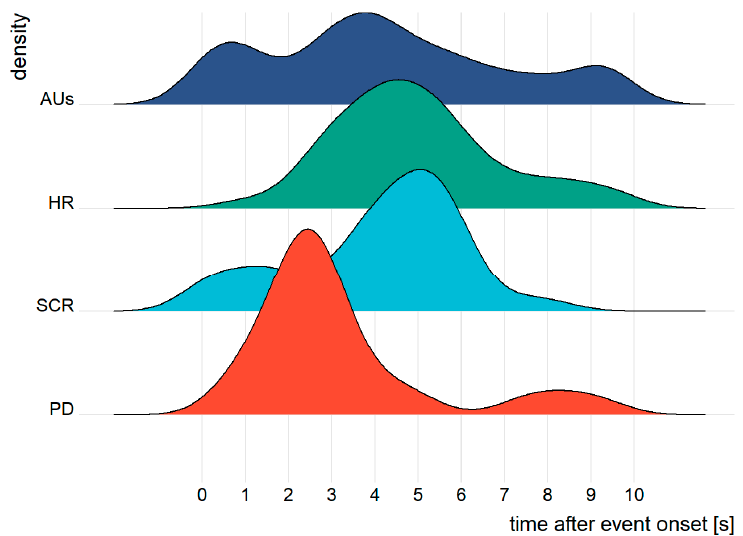
Figure 3. Distributions of peak times of PD (red), SCR (light blue), HR (green) and novelty AUs (dark blue) after event onset.